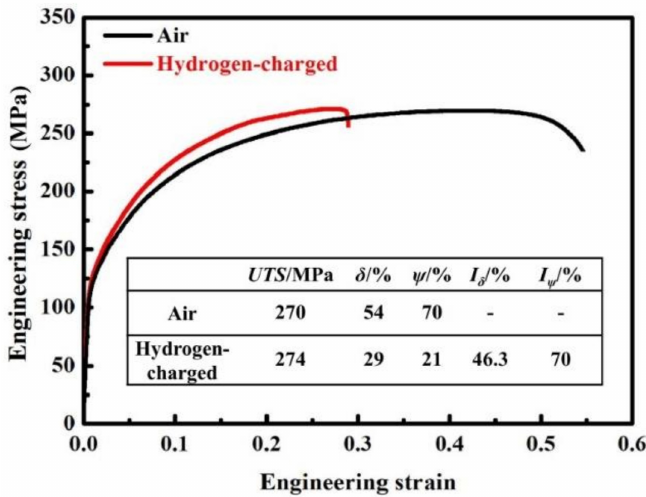
Figure 3. Stress-strain curves of hydrogen-uncharged and hydrogen-charged specimens at a 1 × 10 − 6 s − 1 strain